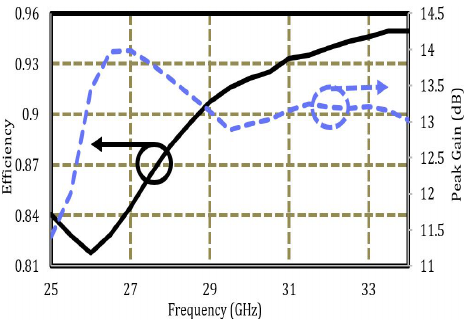
Figure 8. Efficiency and peak